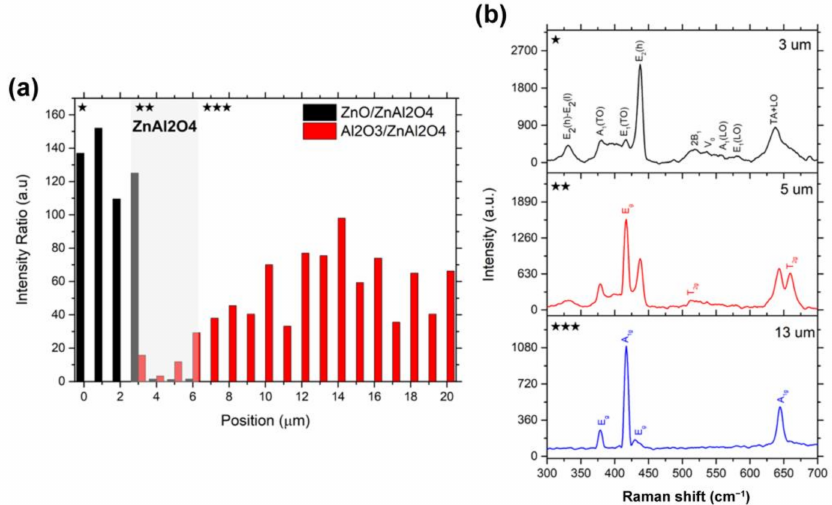
Figure 8. Cross-section data of sample 1000_50: ( a ) estimation of the thickness of the ZnAl 2 O 4 phase due to the ratio of intensities of ZnO and ZnAl 2 O 4 , and Al 2 O 3 and ZnAl 2 O 4 modes; ( b ) the spectra in different registered positions at 3 µ m (the ZnO phase), 5 µ m (the spinel phase), and 13 µ m (Al 2 O 3 phase).